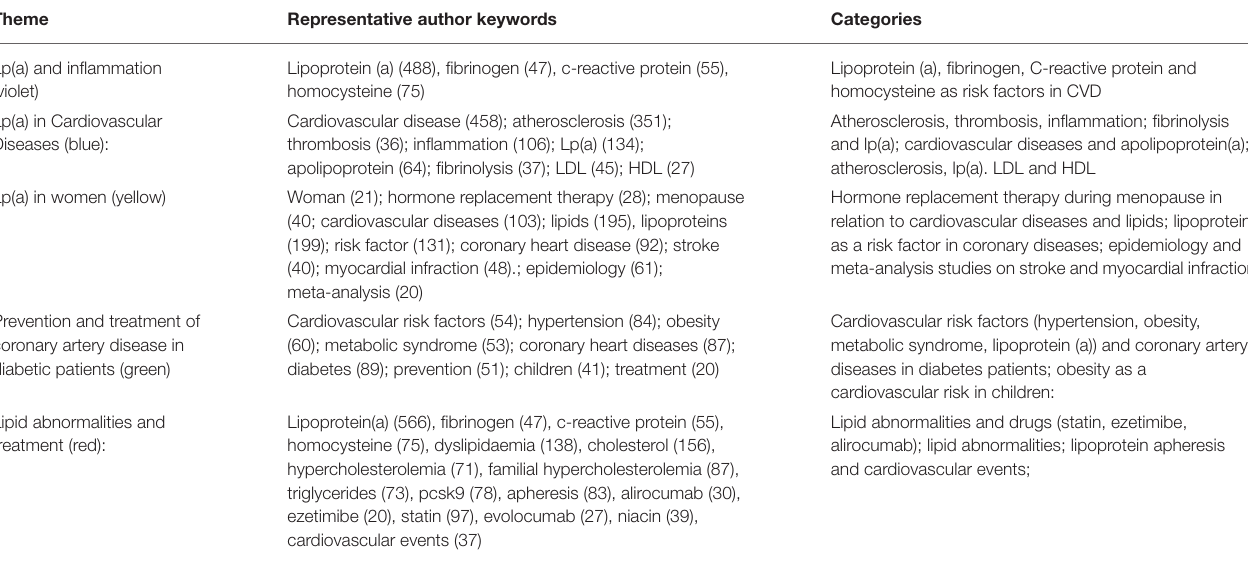
TABLE 4 | Results of the synthetic knowledge